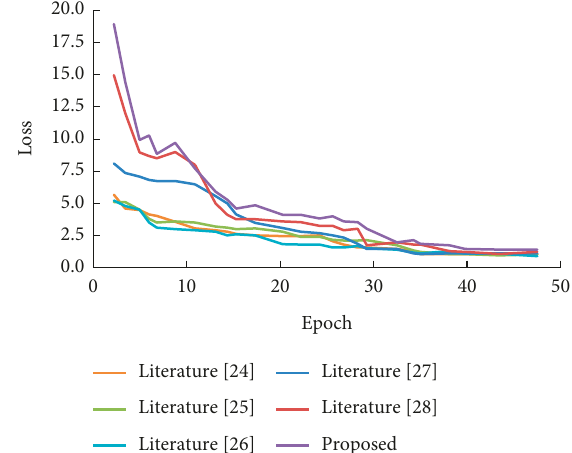
Figure 6: NTU-RGB +D data set training result graph: loss.